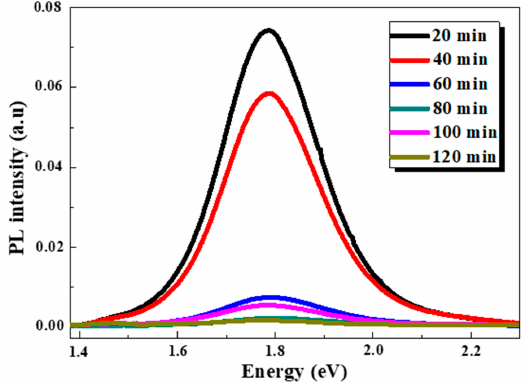
ff erent etching times.